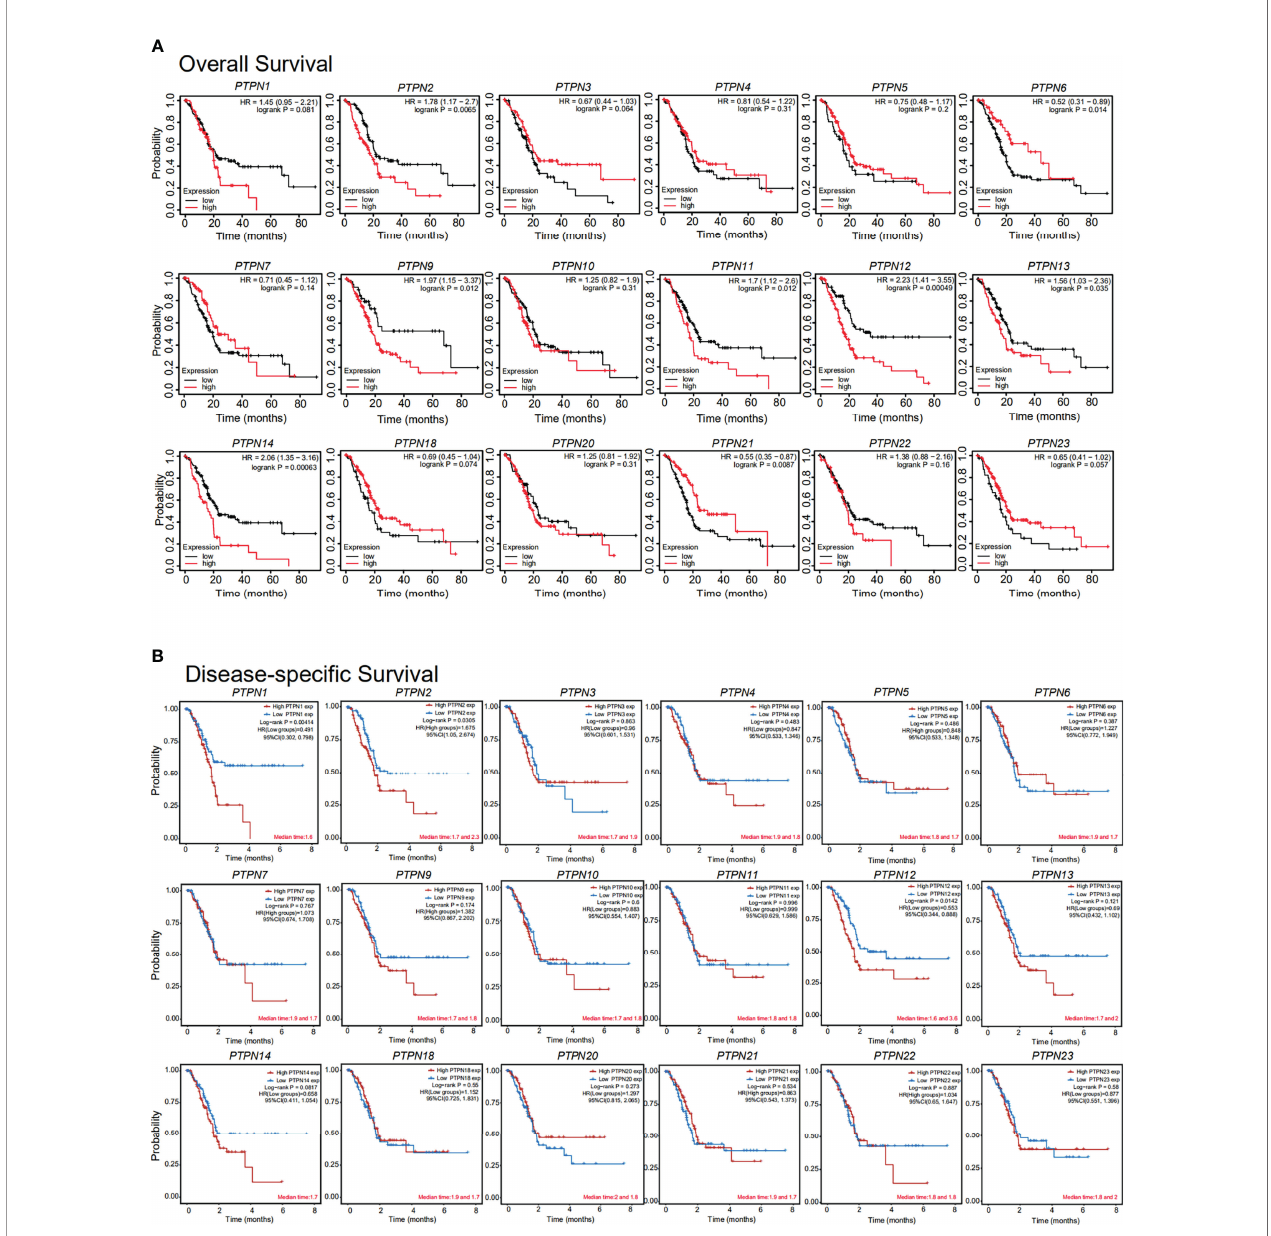
FIGURE 5 | Importance of the mRNA level of PTPNs in the prognosis of patients with pancreatic adenocarcinoma (Kaplan-Meier plot). *p < 0.05, **p < 0.01. HR: Hazard ratios, 95%CI: 95% Con fi dence